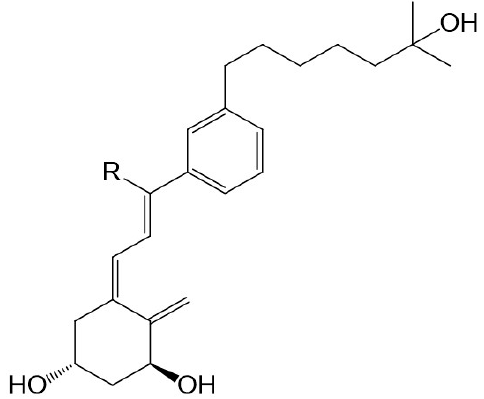
Figure 5. The des -C- m -phenylene-D-21- nor -analogues of 1 α ,25-dihydroxyvitamin D 3 (R = Et, n -Pr, n -Bu, n -Hex, n -Hept).